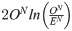
Absence of Lso2 perturbs early elongation.(A) Metaribosome occupancy in a window around the start codon for 28–30 mer footprints. Numbers indicate the respective start codon occupancy in WT and lso2Δ. n = 2 biological replicates; mean ± S.D. (B) Histogram of change in the ratio of start codon to ORF body footprints in lso2Δ versus WT for each gene with ≥64 reads. Black trace (replicate error) indicates the same comparison for WT replicate 1 versus replicate 2. (C) Nucleotide usage bias in the top quartile of genes shown in (B). −1 and +4 indicate the first nucleotide upstream and downstream of the start codon, respectively. At each position, the G-statistic contribution of nucleotide N was calculated as 2ONln(ONEN), where ON is the observed counts of N usage in the top quartile, and EN is the expected counts based on the usage frequency of all genes analyzed. Bonferroni-corrected p-values are indicated by asterisks. *, p < 0.05; **, p < 0.01; ***, p < 0.001, ****, p < 0.0001. (D) Anatomy of ribosome footprint used to calculate pause scores of codon 2 in the A site. The number of read 5′ ends was divided by the density of all in-frame reads within the encoding gene. (E) Empirical cumulative distribution of pausing at +2 serine codons in the A site, which are challenging to translate in lso2Δ. Each trace is from merged WT and lso2Δ replicates, respectively. (F) For each indicated +2 codon in the A site, empirical cumulative distributions of pause scores were computed for WT and lso2Δ as in (E). The K-S p-value and median shift of lso2Δ versus WT pause-score distributions are plotted. The 8 most challenging +2 codons (median increase > 1.78-fold, p-value < 10−6) are highlighted. (G) For the 8 challenging +2 codons highlighted in (F), the median pause shift was also calculated in the same manner for each of codon positions +3 to +10. Calculations are based on the specified codon filling the A site. K-S, Kolmogorov-Smirnov; Lso2, late-annotated short open reading frame 2; WT, wild type.